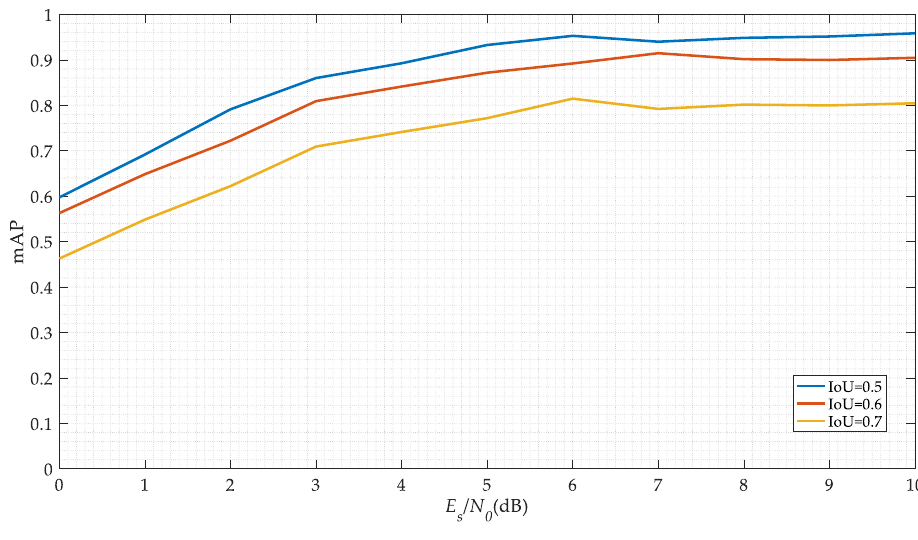
Figure 11. The SSD networks performances.